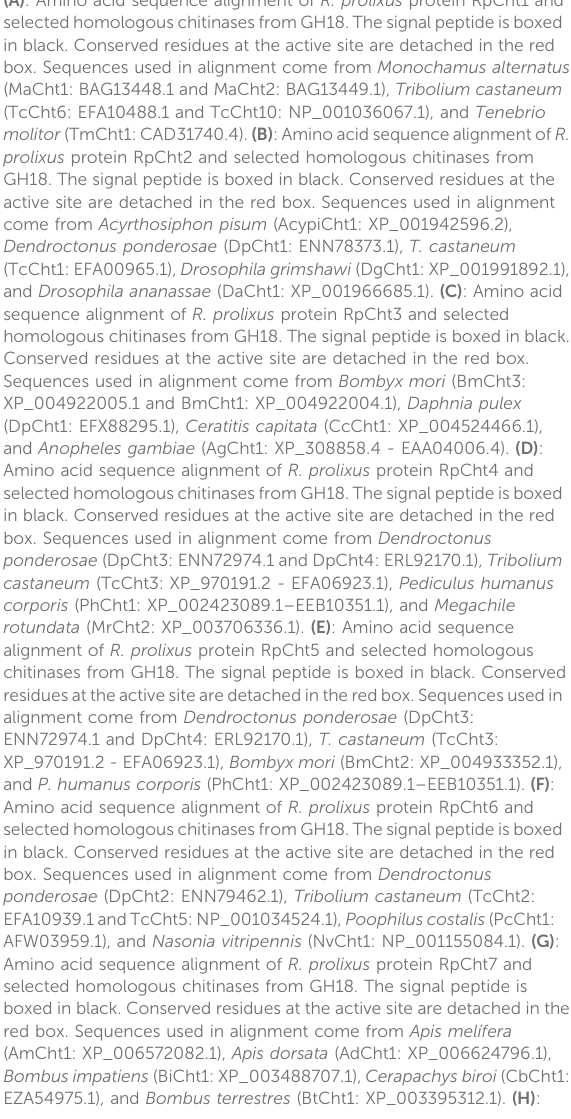
SUPPLEMENTARY FIGURE S1 (A) : Amino acid sequence alignment of R. prolixus protein RpCht1 and selectedhomologouschitinases fromGH18.Thesignal peptideisboxed in black. Conserved residues at the active site are detached in the red box. Sequences used in alignment come from Monochamus alternatus (MaCht1: BAG13448.1 and MaCht2: BAG13449.1), Tribolium castaneum (TcCht6: EFA10488.1 and TcCht10: NP_001036067.1), and Tenebrio molitor (TmCht1:CAD31740.4). (B) :Aminoacidsequencealignmentof R. prolixus protein RpCht2 and selected homologous chitinases from GH18. The signal peptide is boxed in black. Conserved residues at the active site are detached in the red box. Sequences used in alignment come from Acyrthosiphon pisum (AcypiCht1: XP_001942596.2), Dendroctonus ponderosae (DpCht1: ENN78373.1), T. castaneum (TcCht1: EFA00965.1), Drosophila grimshawi (DgCht1: XP_001991892.1), and Drosophila ananassae (DaCht1: XP_001966685.1). (C) : Amino acid sequence alignment of R. prolixus protein RpCht3 and selected homologous chitinases from GH18. The signal peptide is boxed in black. Conserved residues at the active site are detached in the red box. Sequences used in alignment come from Bombyx mori (BmCht3: XP_004922005.1 and BmCht1: XP_004922004.1), Daphnia pulex (DpCht1: EFX88295.1), Ceratitis capitata (CcCht1: XP_004524466.1), and Anopheles gambiae (AgCht1: XP_308858.4 - EAA04006.4). (D) : Amino acid sequence alignment of R. prolixus protein RpCht4 and selectedhomologouschitinases fromGH18.Thesignal peptideisboxed in black. Conserved residues at the active site are detached in the red box. Sequences used in alignment come from